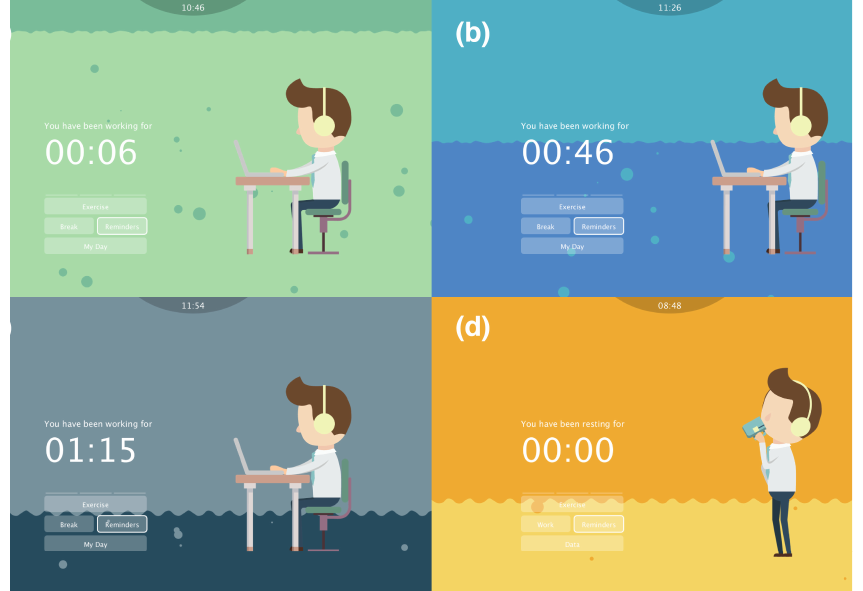
Figure 4. Overview of the home page in di ff erent states: working less than 30 min since ( a ) the last break; ( b ) 30–60 min since the last break; ( c ) over 1 h since the last break; and ( d )